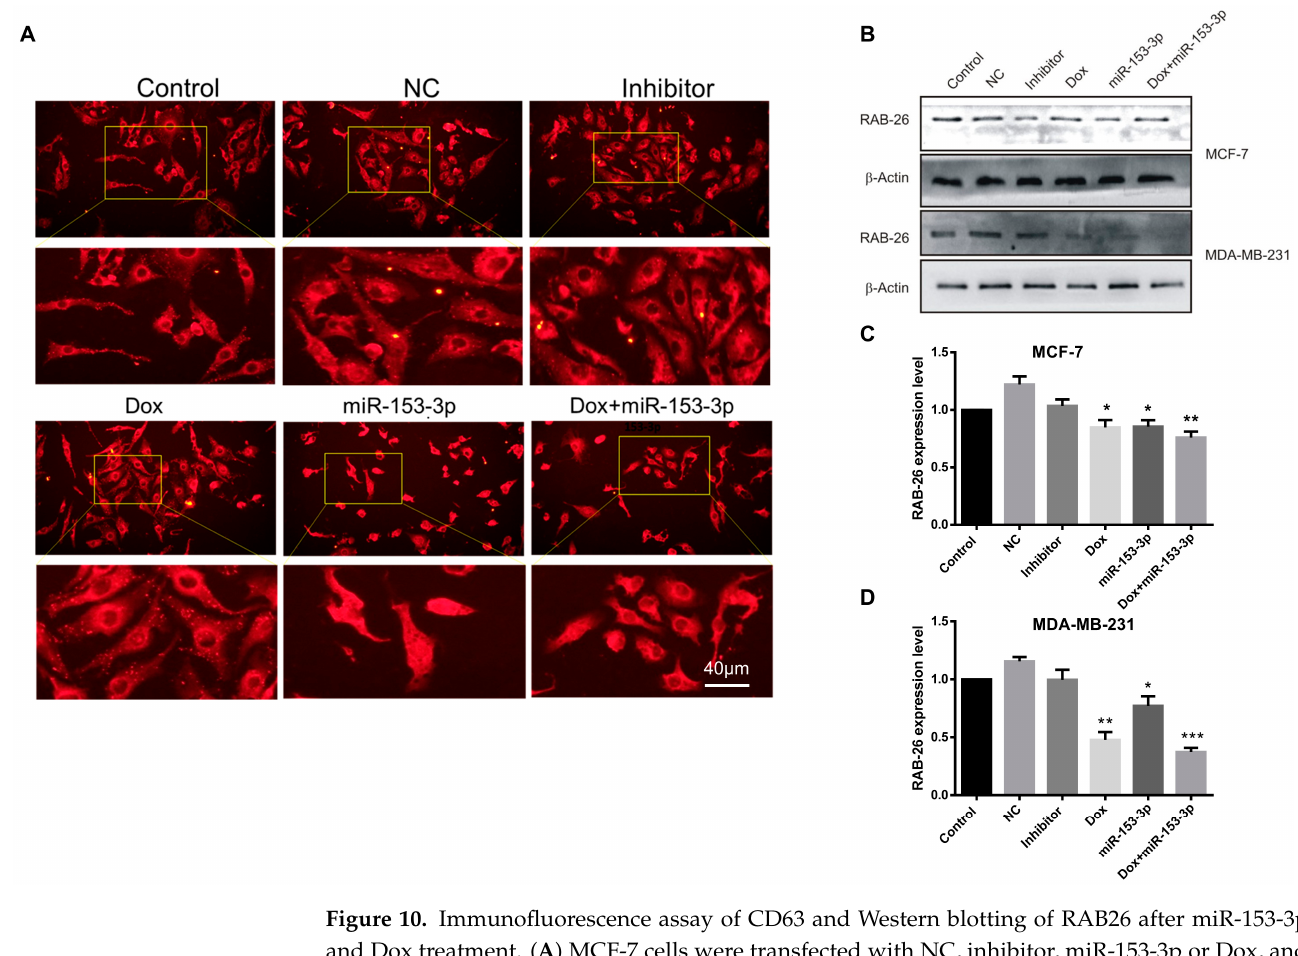
Figure 10. Immunofluorescence assay of CD63 and Western blotting of RAB26 after miR-153-3p and Dox treatment. ( A ) MCF-7 cells were transfected with NC, inhibitor, miR-153-3p or Dox, and miR-153-3p+Dox for 24 h. ( B – D ) Western blotting of RAB26 and its quantitative analysis in MCF-7 cells. Scale bar = 40 µ m (* p < 0.05; ** p < 0.01; *** p < 0.001, original blot see Supplementary File S1).